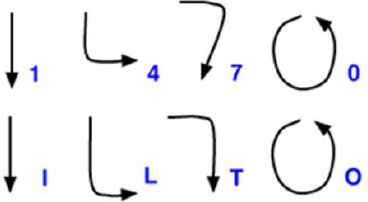
Figure 4. The pairs of the same or slightly different gestures. Reprinted with permission from [17]. The data were transferred and recorded at 40 Hz from the watch to the tablet. The data include accelerometer and gyro values in three axes and the gravity-removed accelerometer values provided by the watch using a linear filter.